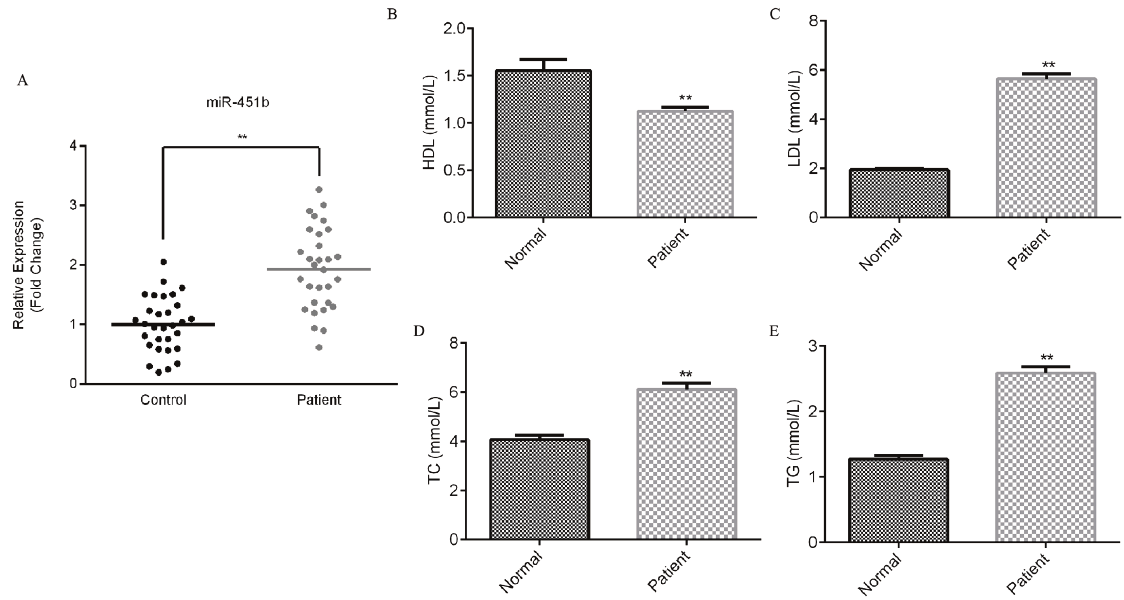
Figure 1. miR-451b is up-regulated in the serum of patients with coronary heart disease. (A) qRT-PCR assay detected the relative expression of miR-451. (B-E) ELISA assay detected the level of high density lipoprotein, low density lipoprotein, serum total cholesterol, and triglyceride in the serum of patients with coronary heart disease.